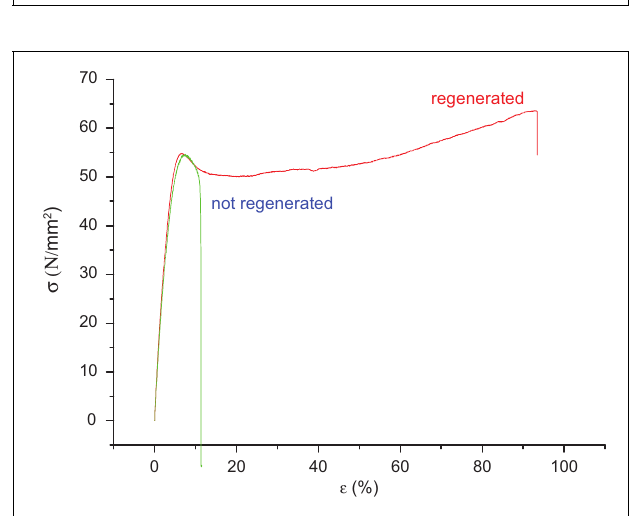
the phase angle (tan δ ), which is defined as ratio of the loss modu- lus (related to the viscous response of the polymer) to the storage modulus. The phase angle is very sensitive to phase transitions, and especially to the glass transition of the polymer Tg (Hou et